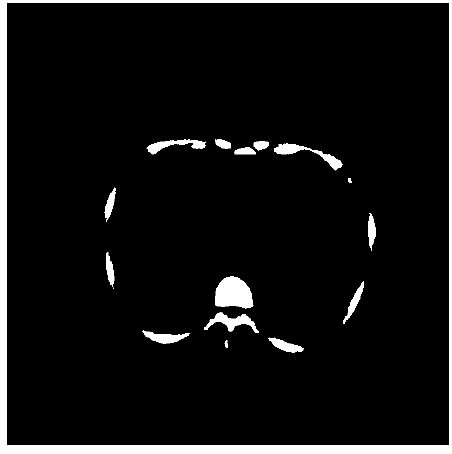
Fig. 2. Pixels representing bone tissue.